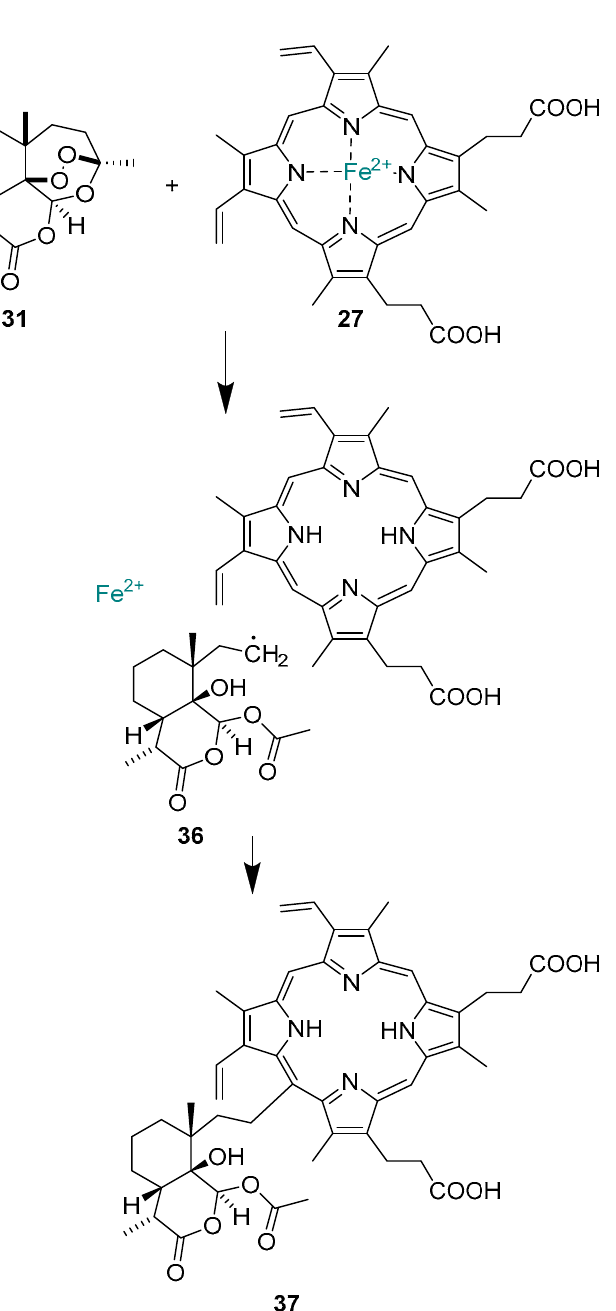
Figure 12. Synthetic antimalarial drugs. Mefloquine and amodiaquine are included in WHO list of essential medicines. (https://www.who.int/medicines/publications/essentialmedicines/en/, accessed on 1 April 2021). 2.1.11. Resistance toward Artemsinins In spite of the precautions artemisinin resistance defined a decreased sensitivity for artemisinins have occurred in South East Asia from China to India, in Equitorial Guinea and Uganda in Africa [85]. Considering the burden of malaria in Africa the development on this continent is particularly alarming. Parasites resistant to artemisinins are characterized by the presence of PfK13 mutations. The Kelch 13 proteins are substrate for an E3-ligase, which bind to phosphatidylinositol-3-kinase and marks it for ubiquitination and eventually